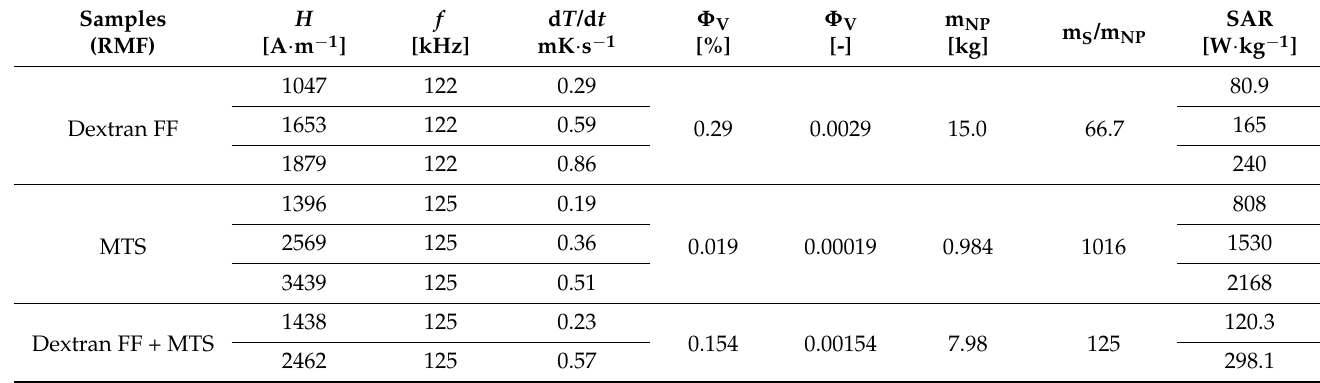
Table 2. AMF parameters ( H and f ) and heating rate (d T /d t ) of tested samples.